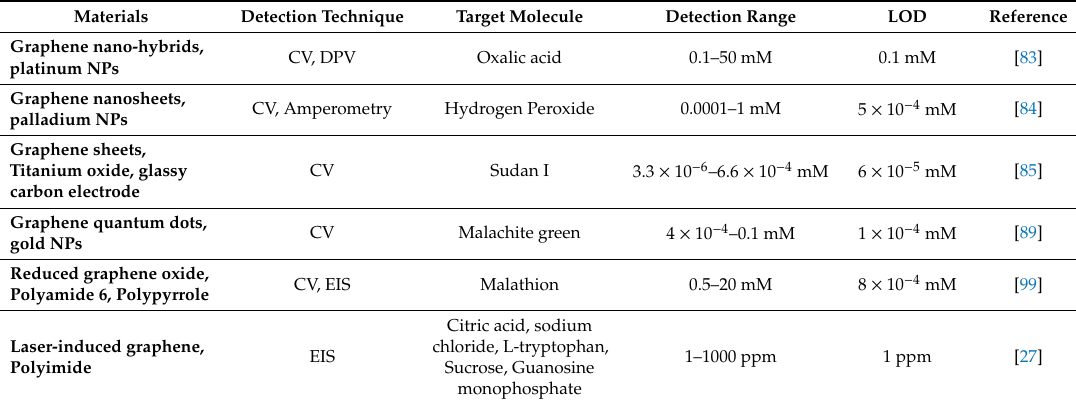
Table 4. Summary of the graphene-based sensors used for the detection of food